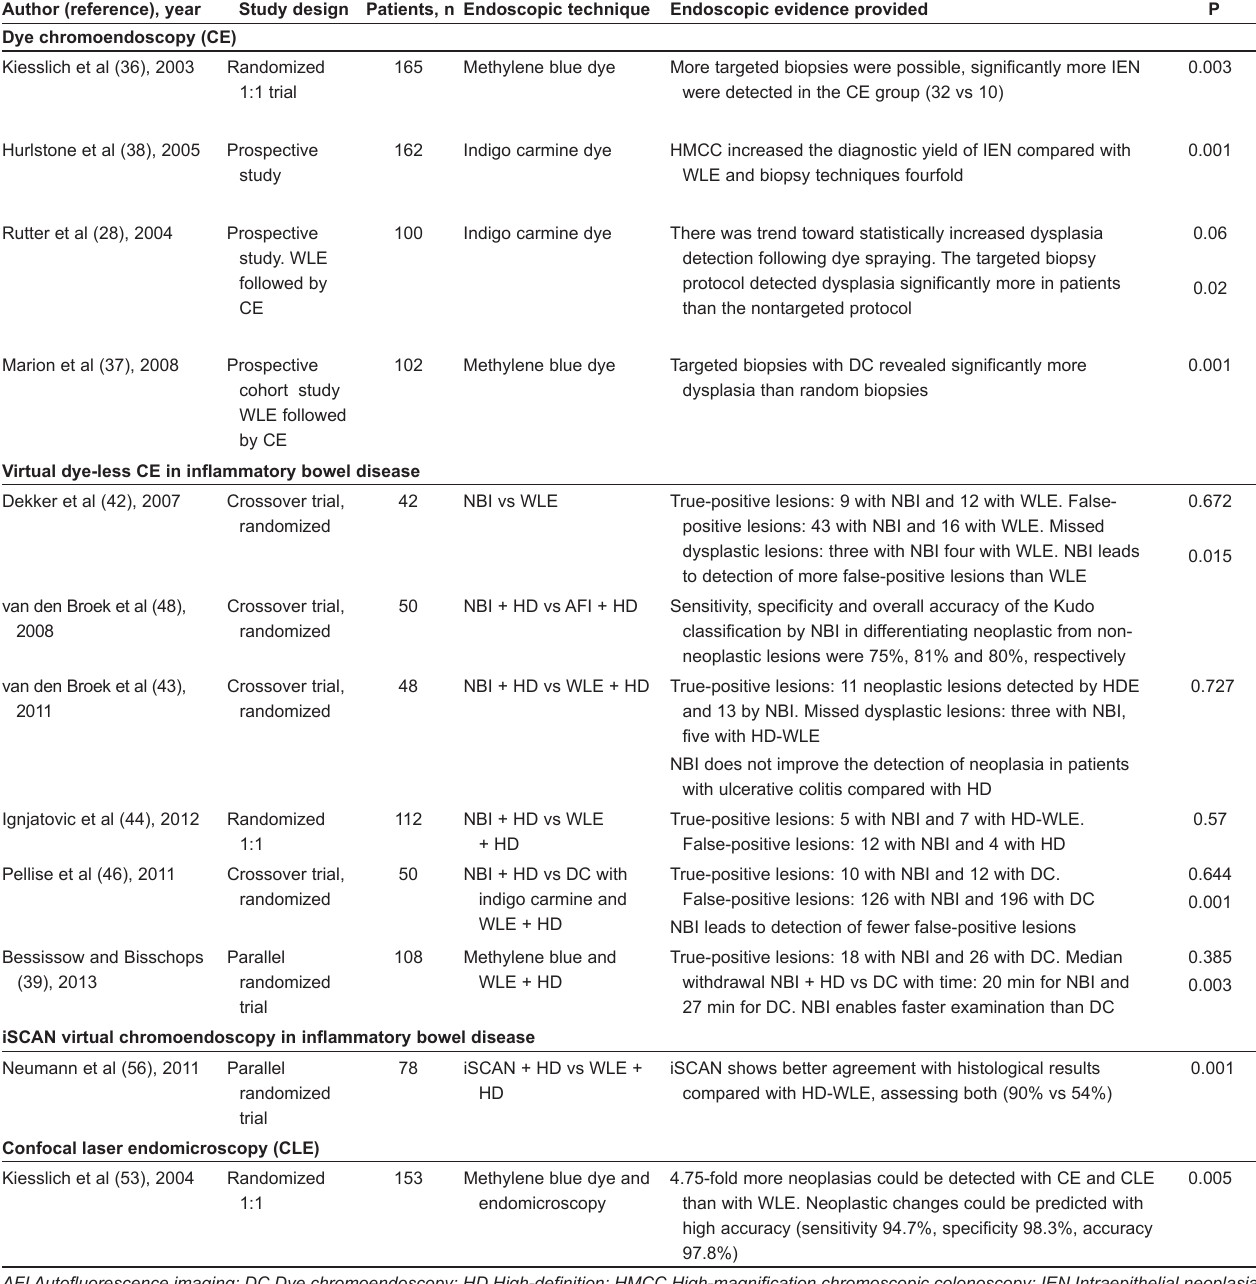
TAble 1 Studies of chromoendoscopy, autofluorescence imaging (AFI) and narrow-band imaging Author (reference), year Study design Patients, n endoscopic technique endoscopic evidence